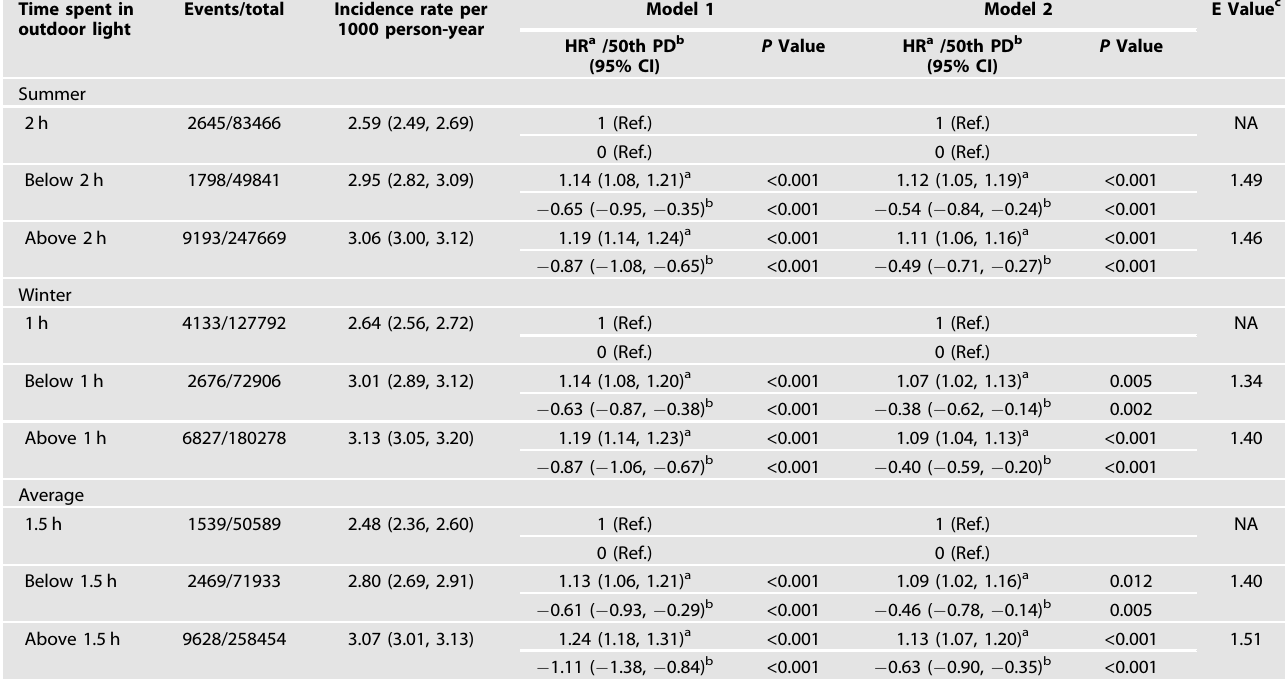
Table 2. Hazard ratios (HRs) and 50th percentile differences (PDs, in years) of incident depression.